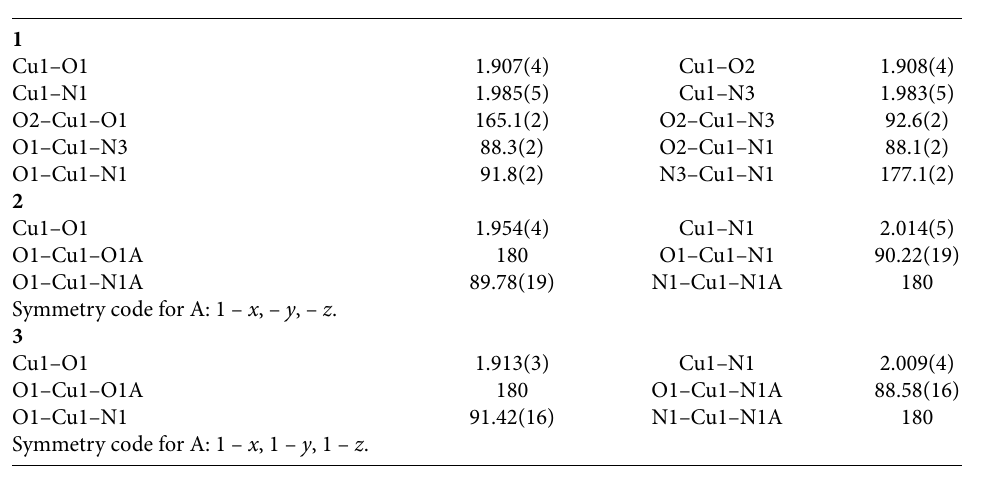
Table 2. Selected bond distances (Å) and angles (°) for the